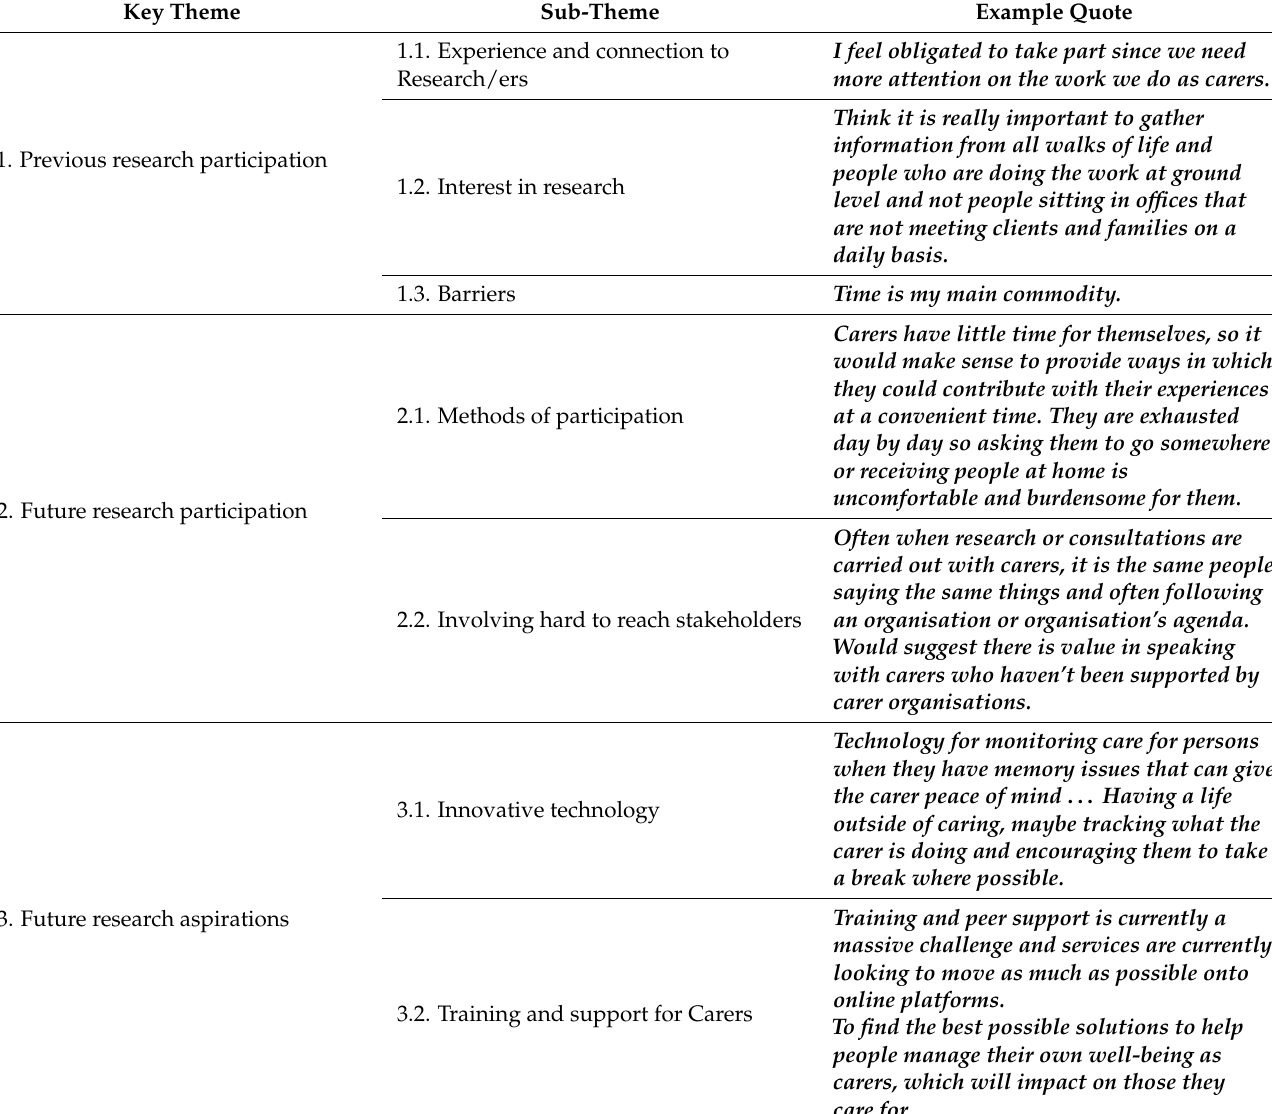
Table 3. Key themes and sub-themes from Professionals